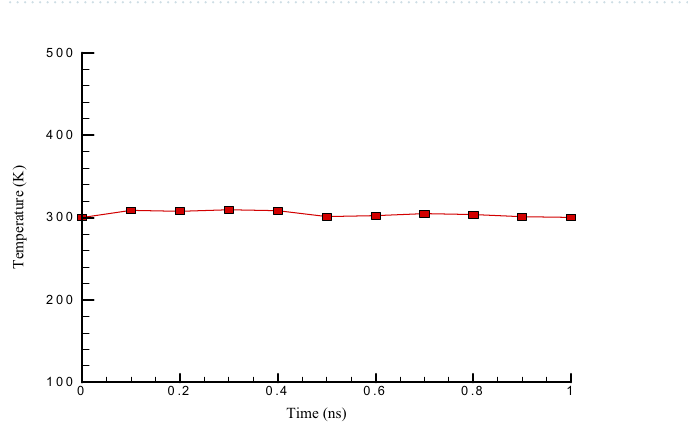
Figure 1. The schematic of a simulated carbon nanotube system and ultrasonic fluid (argon) which is created in LAMMPS 9,18,19 .